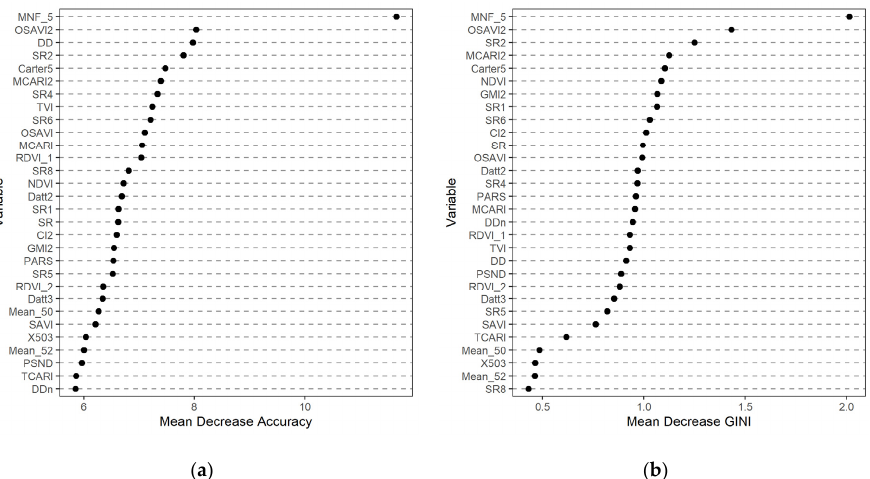
Figure 6. Variable importance plots for the most important 30 variables of the map-making model. ( a ) Mean Decrease Accuracy; ( b ) Mean Decrease GINI.